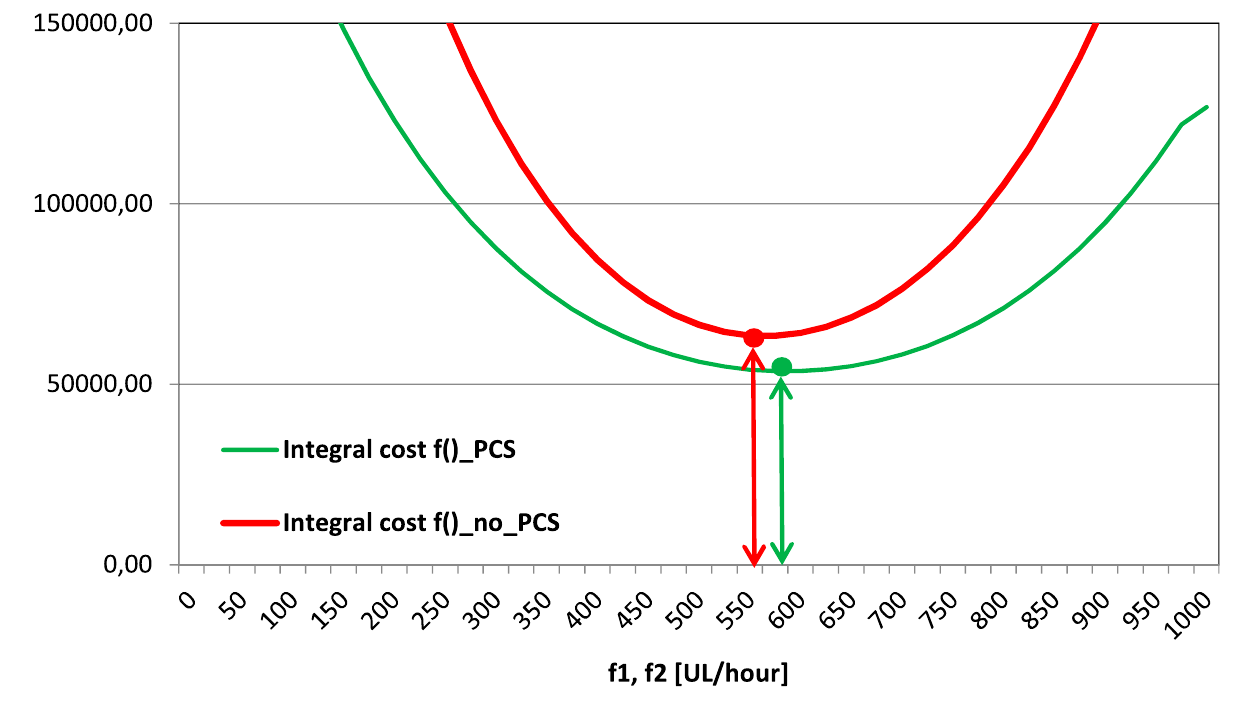
FIGURE 2 | Integral cost function ( ζ ) of ports 1 and 2 with and without PCS ( Eq. 4.2 ).